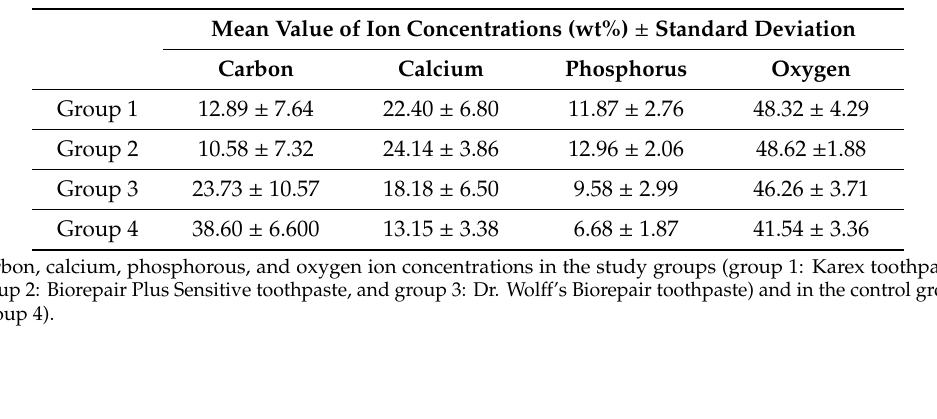
Table 3. Mean values and standard deviation of carbon, calcium, phosphorus, and oxygen ion concentration (wt%) in control and study